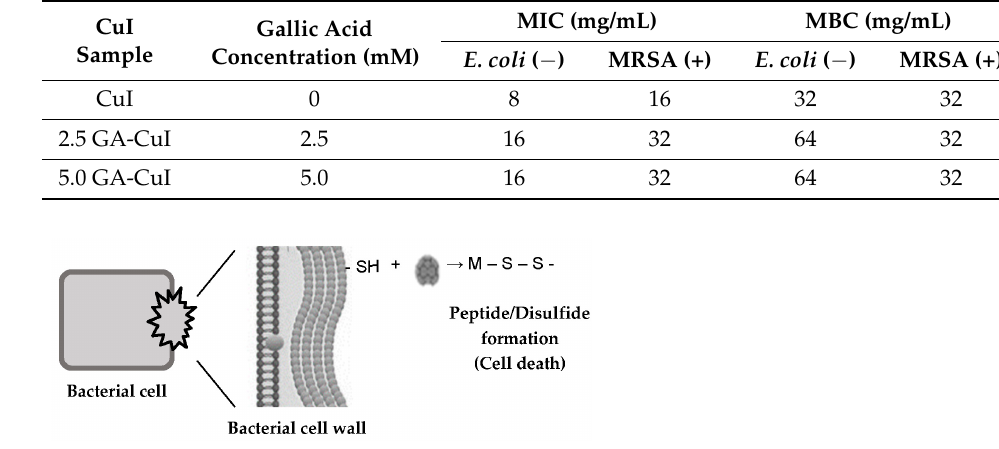
Figure 8. Antibacterial mechanism of CuI NPs through denaturation.